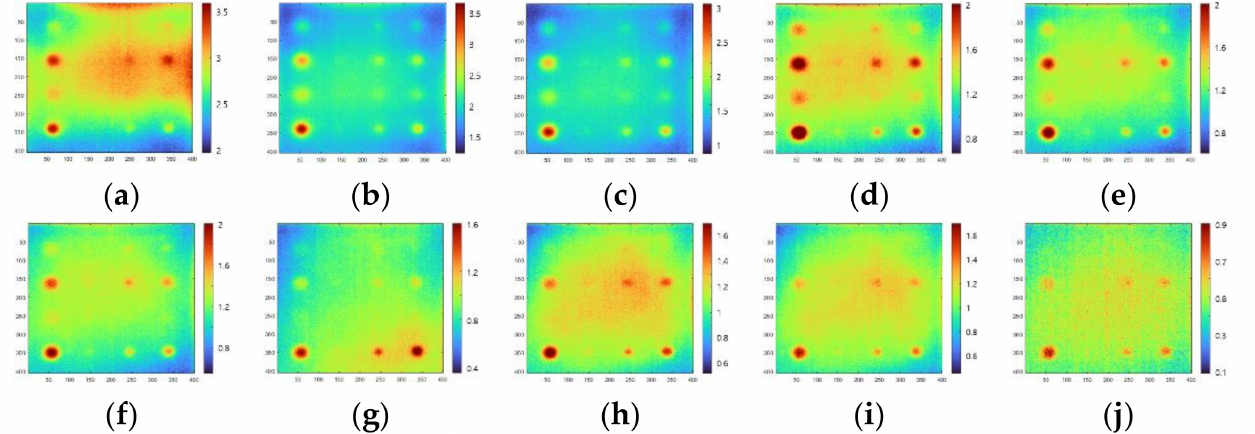
Figure 5. Amplitude images from the lock-in signal processing: ( a ) 0.01 Hz, ( b ) 0.02 Hz, ( c ) 0.03 Hz, ( d ) 0.04 Hz, ( e ) 0.05 Hz, ( f ) 0.06 Hz, ( g ) 0.07 Hz, ( h ) 0.08 Hz, ( i ) 0.09 Hz and ( j ) 0.1 Hz.